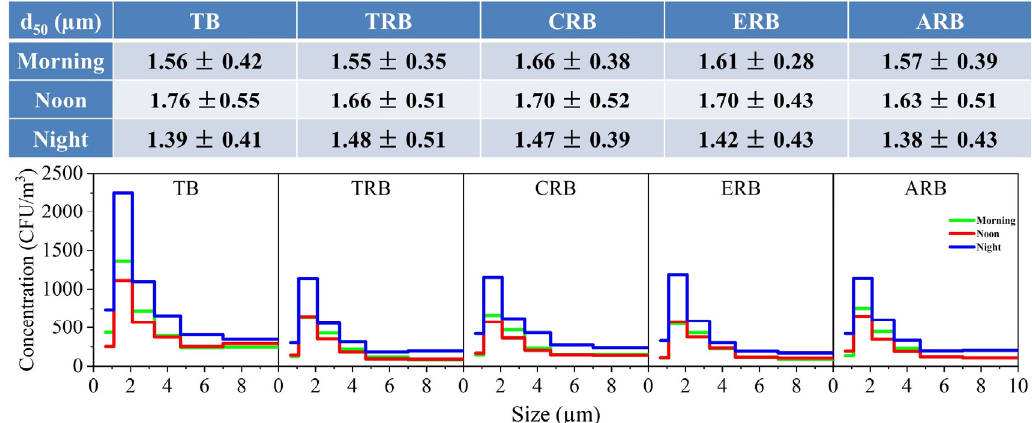
Figure 3. Diurnal variation in size distribution and median diameter of culturable bacteria and four antibiotic-resistant bacteria (the diameter corresponding to a cumulative percentage of 50% is the median diameter (d 50 )).